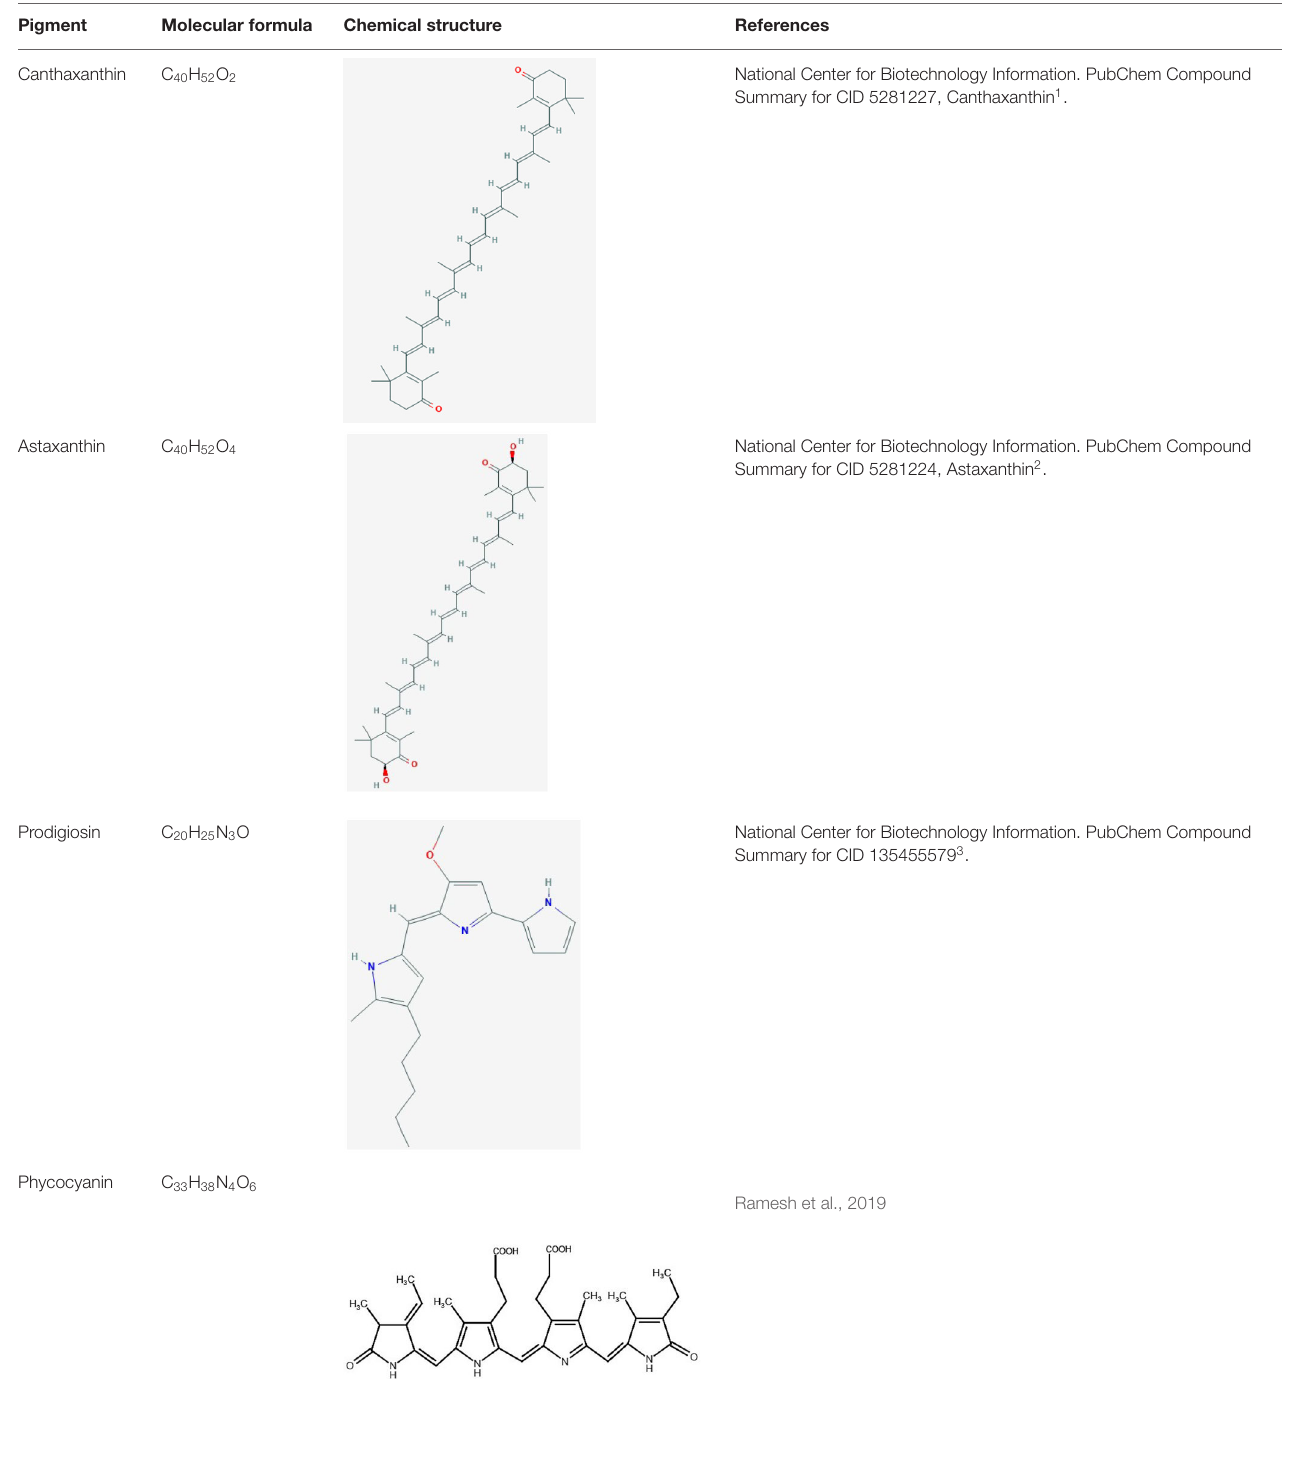
TABLE 1 | Structural details of important microbial pigments used as food colorants. Pigment Molecular